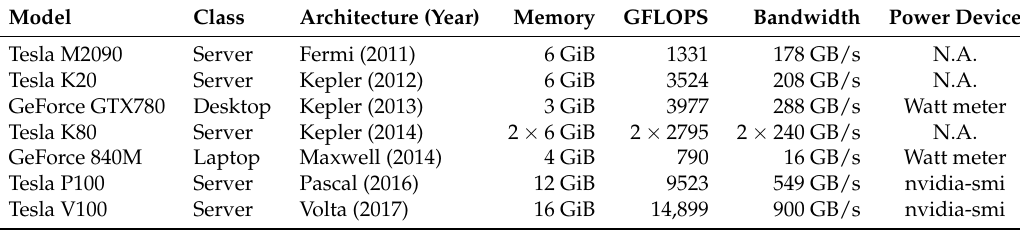
Table 2. A list of the GPUs used in this work. The profile-driven development was carried out on the 840M and GTX780, and the remaining high-end GPUs were used for performance benchmarking. We used the 840M, GTX780, P100, and V100 for benchmarking power efficiency. Note that the performance in giga floating point operations per second (GFLOPS) is for single precision. The K80 GPU consists of two processors on the same card and has a boost feature for temporarily increasing the clock speed to increase performance to 2 4368 ×